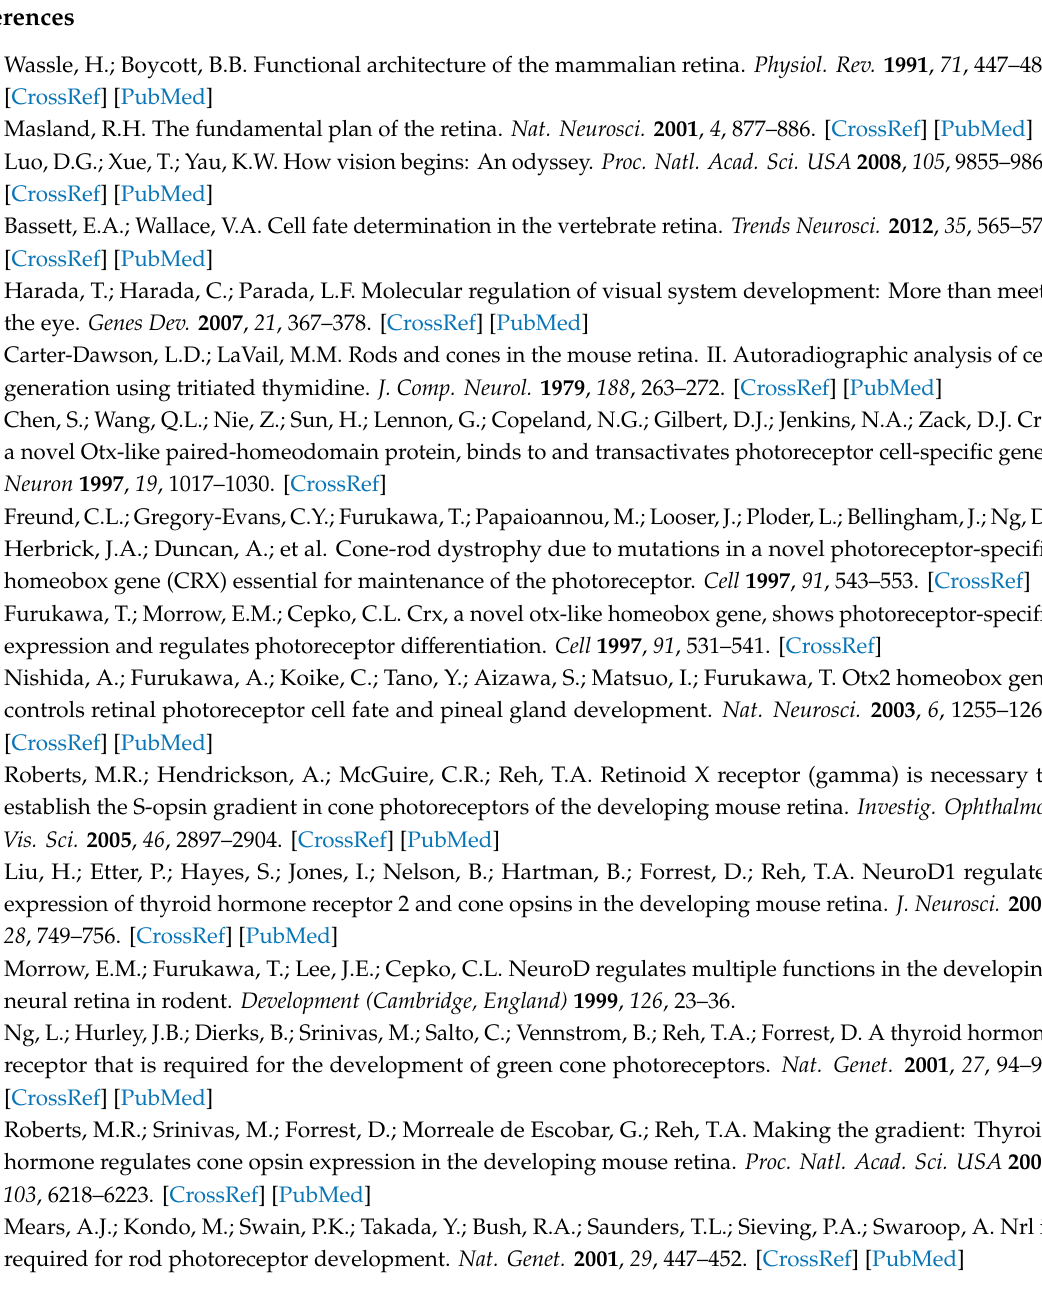
mice, Figure S3. The expression changes of Jra after 3 h blue light exposure in fly photoreceptor, Figure S4. The predicted c-Jun binding sites in the c-Jun ChIP-seq peak